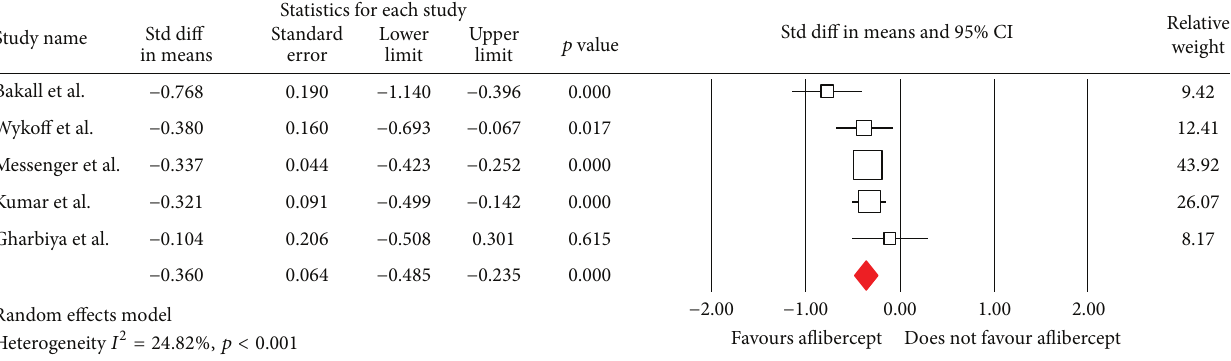
Figure 3). The random model was used as heterogeneity of the data (𝐼 2 ) was 66.79%. The weighted regression on the 5 studies included for covariates (mean number of anti-VEGF prior to switching to aflibercept, total length of treatment with anti-VEGF prior to switching, mean BCVA at switching, and at 6